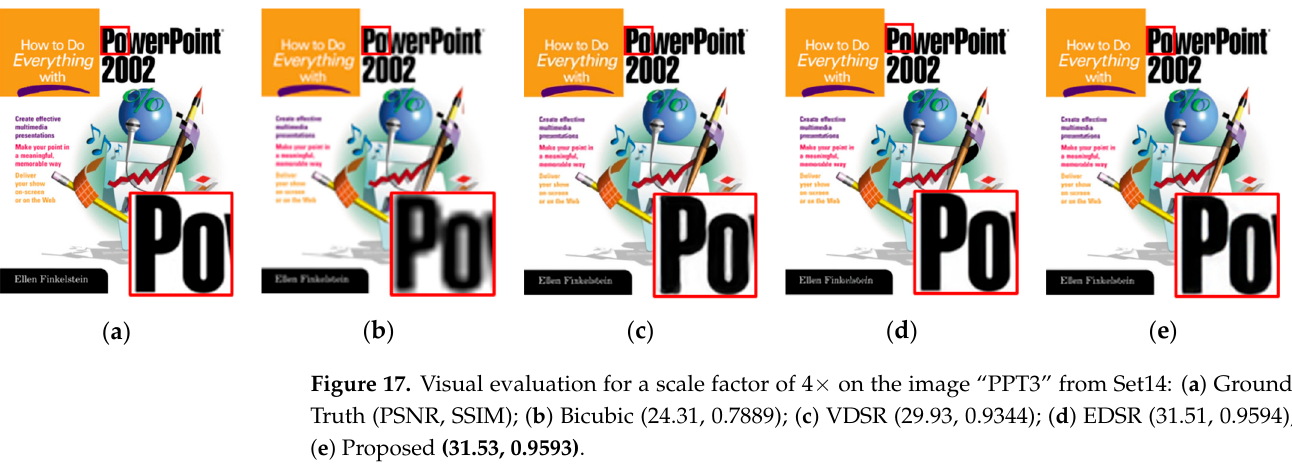
Truth (PSNR, SSIM); ( b ) Bicubic (30.70, 0.7447); ( c ) VDSR (34.28, 0.8699); ( d ) EDSR (35.85, 0.8832);